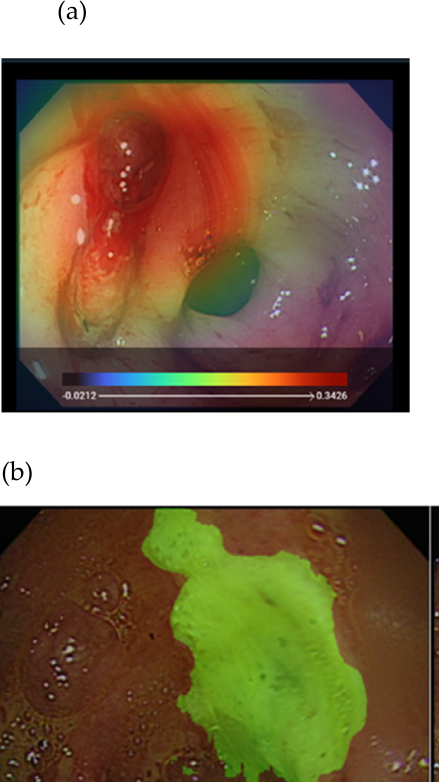
Figure 2. Forrest classification of bleeding peptic ulcers.